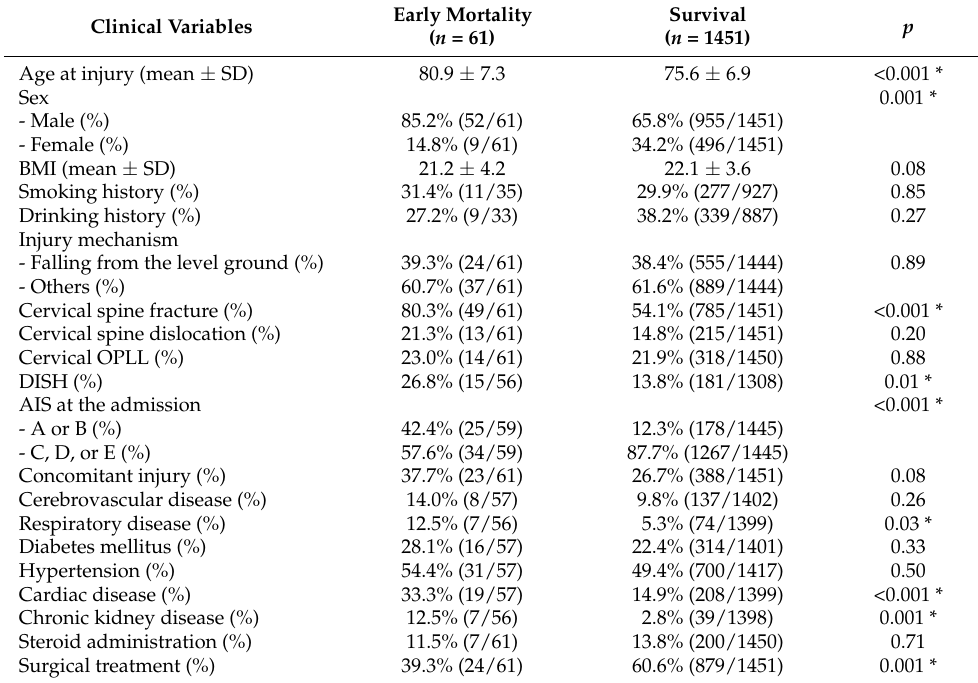
Table 2. Comparison between the survival and early mortality